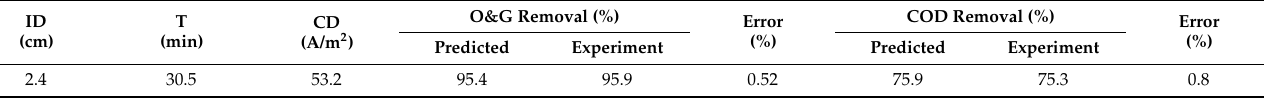
Table 7. Optimisation of the O&G and COD removal from the experiment and predicted value.